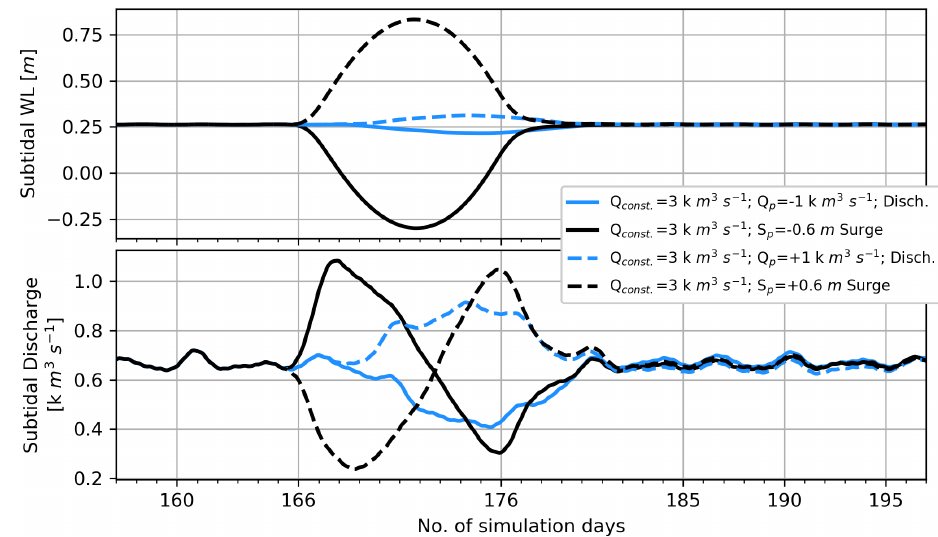
Figure 11. Upstream (in Can Tho) subtidal water level and discharge response to variation in discharge and surge